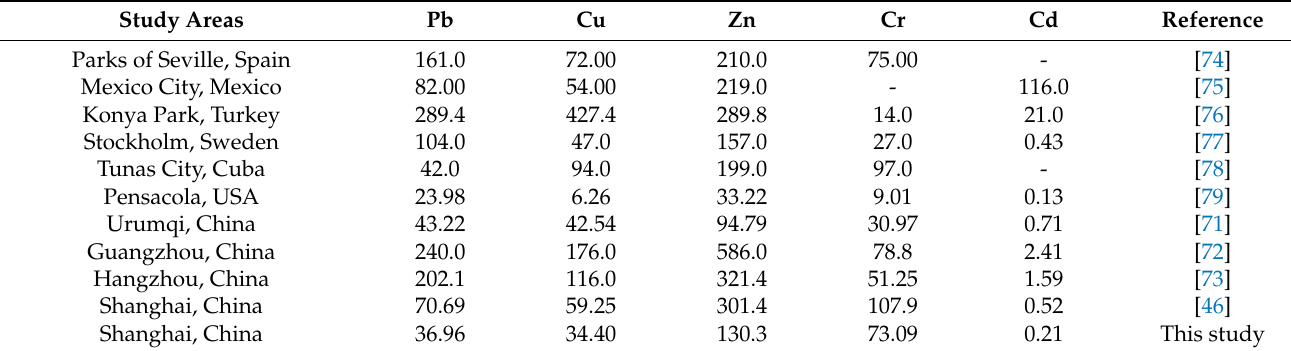
Table 2. PTE mean concentrations level (mg kg − 1 ) of sampling of global urban green space areas. Study